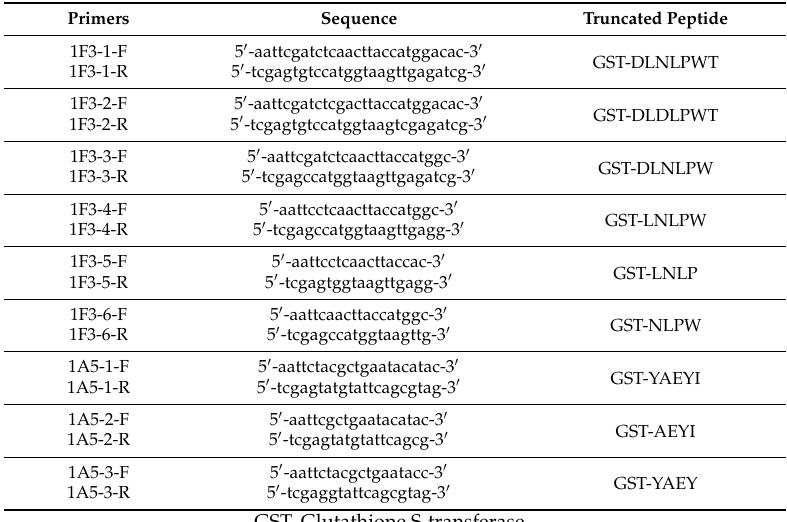
Table 2. Primers for the truncated epitope fragments.